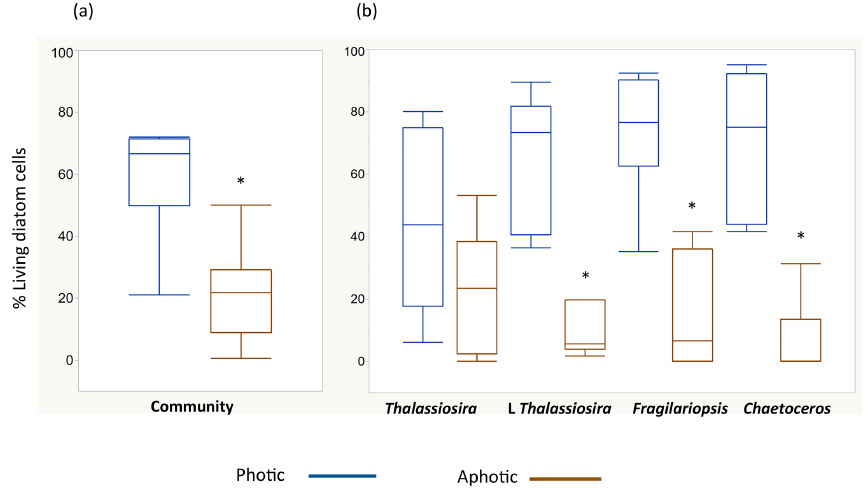
Figure 3. Box plots showing the distribution of the percentage of living diatoms in the photic (blue) and aphotic (brown) layers. Percentage of living cells among (a) the total diatom community and (b) for the populations of the most abundant diatom taxa observed during the cruise. The asterisks indicate significant differences between photic and aphotic zones ( P < 0 . 05). Boxes encompass the central 50% of the data, the horizontal line inside the box represents the median, and vertical bars encompass 90% of the data.